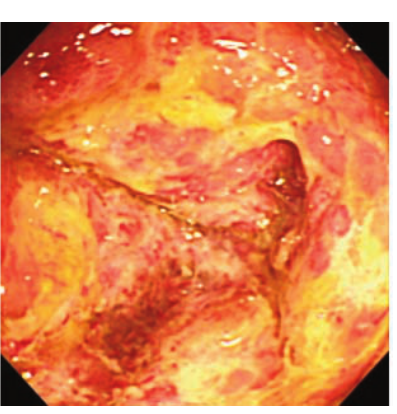
Figure 2. Colonoscopic image indicating significant mucous membrane swelling with pus in the